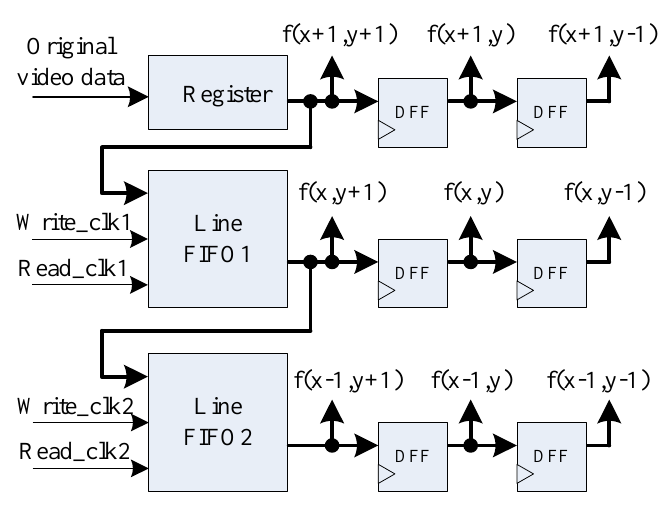
Figure 5. Architecture of a 3 × 3 pixel template cache.